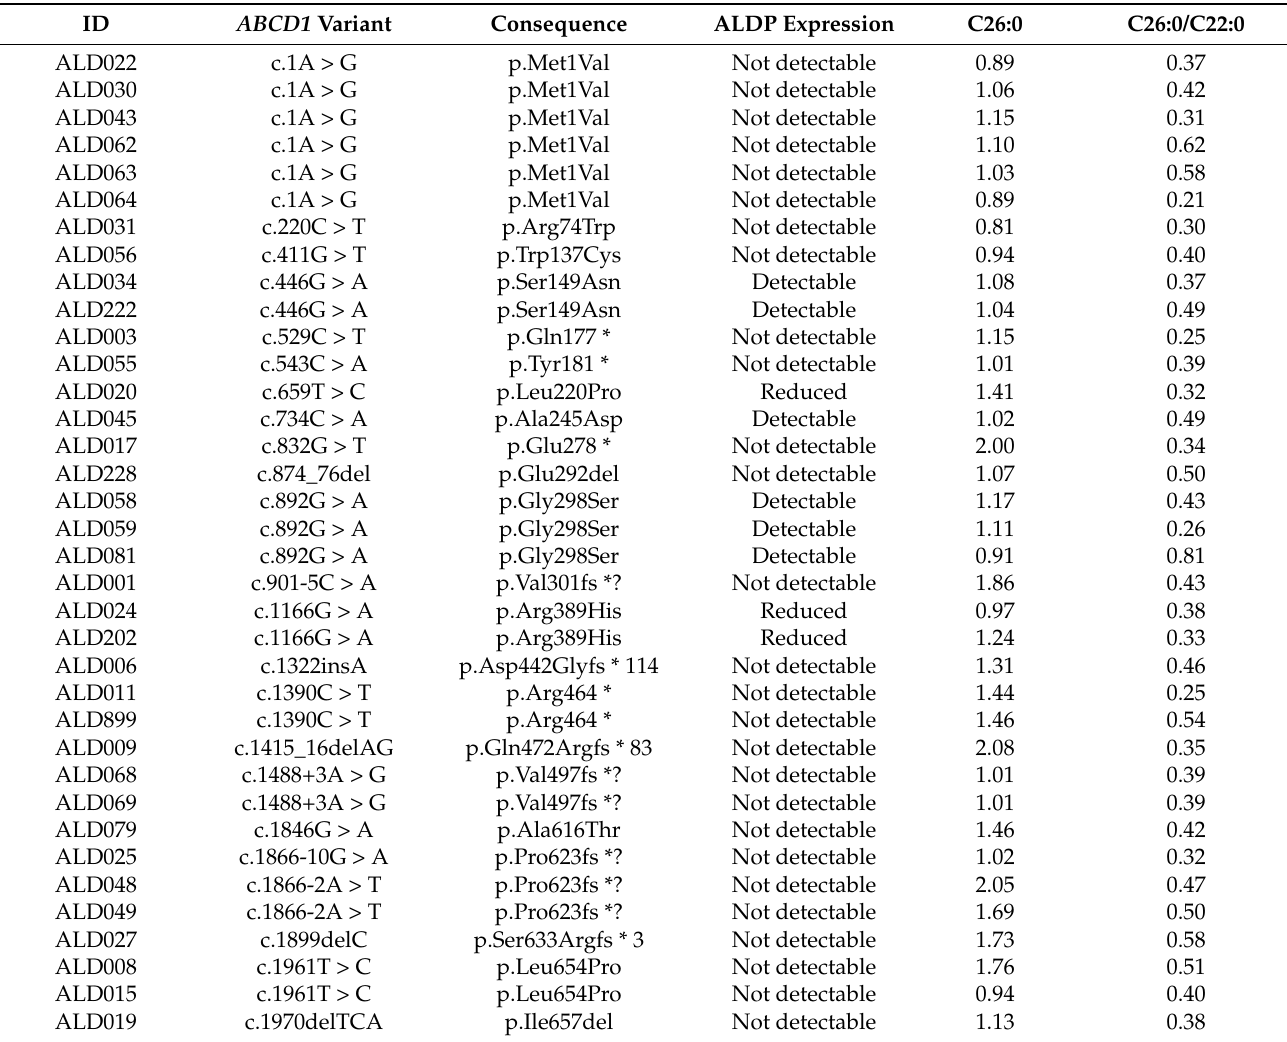
Table 1. ABCD1 variants, the effect on ALDP expression and VLCFA levels in fibroblasts of the ALD patients included in the